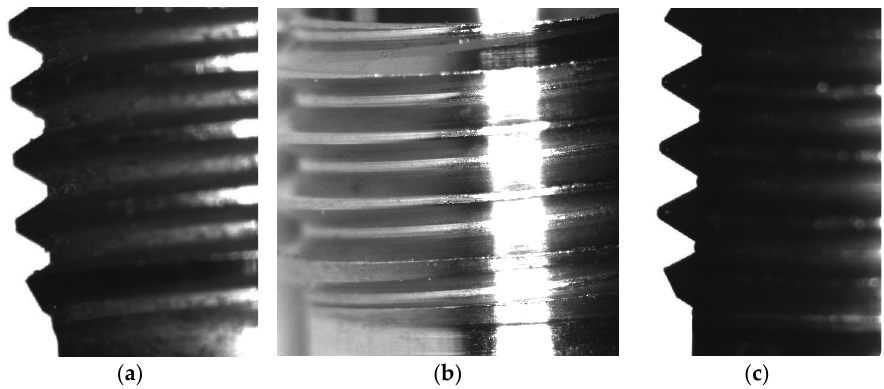
Figure 5. Thermal pulse thread processing: ( a ) the part with burrs before processing; ( b , c ) the part after processing in the rational mode of P = 1 760 kPa with burrs removed and surface quality and thread dimensions preserved.